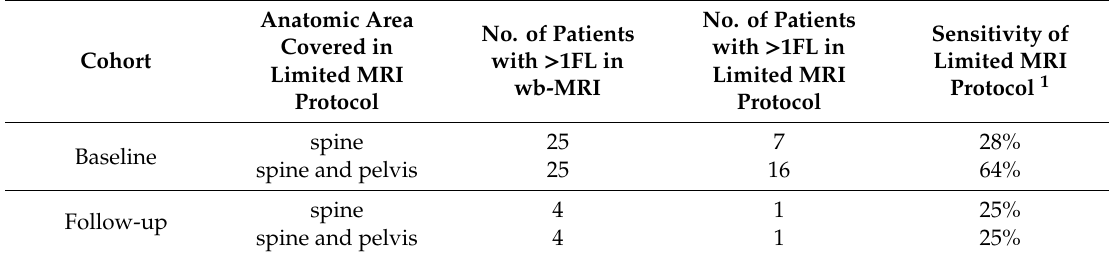
Table 1. Performance of MRI protocols limited to spine / spine plus pelvis regarding detection of patients with >1 focal lesion (FL) in whole-body MRI.